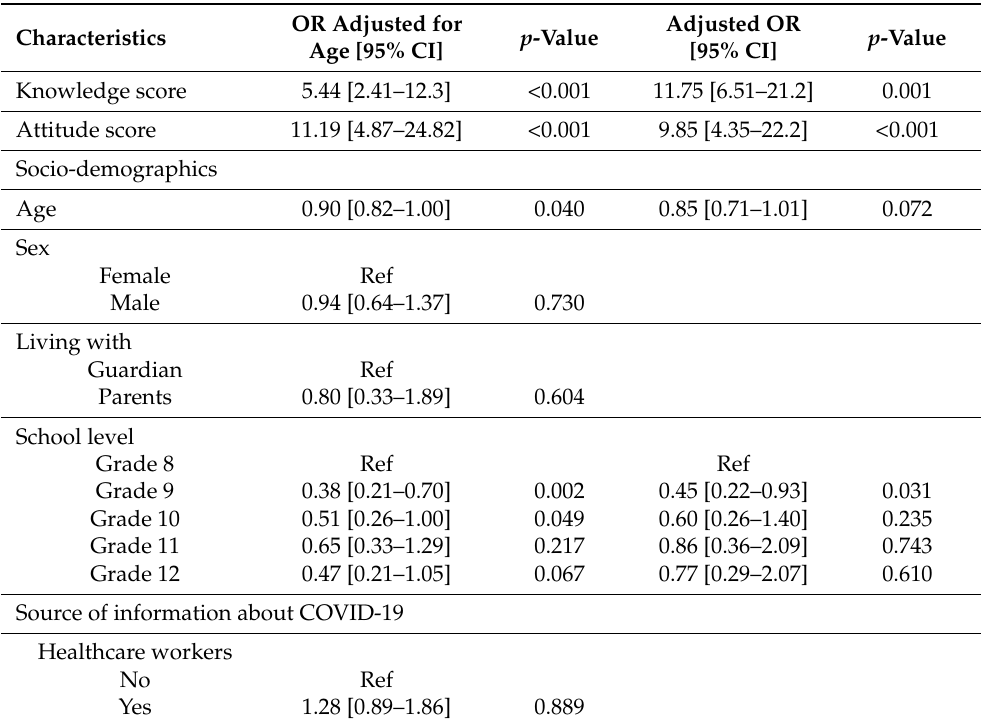
Table 3. Association between respondent’s knowledge and attitude scores and acceptance of COVID- 19 vaccines, adjusting for potential confounding